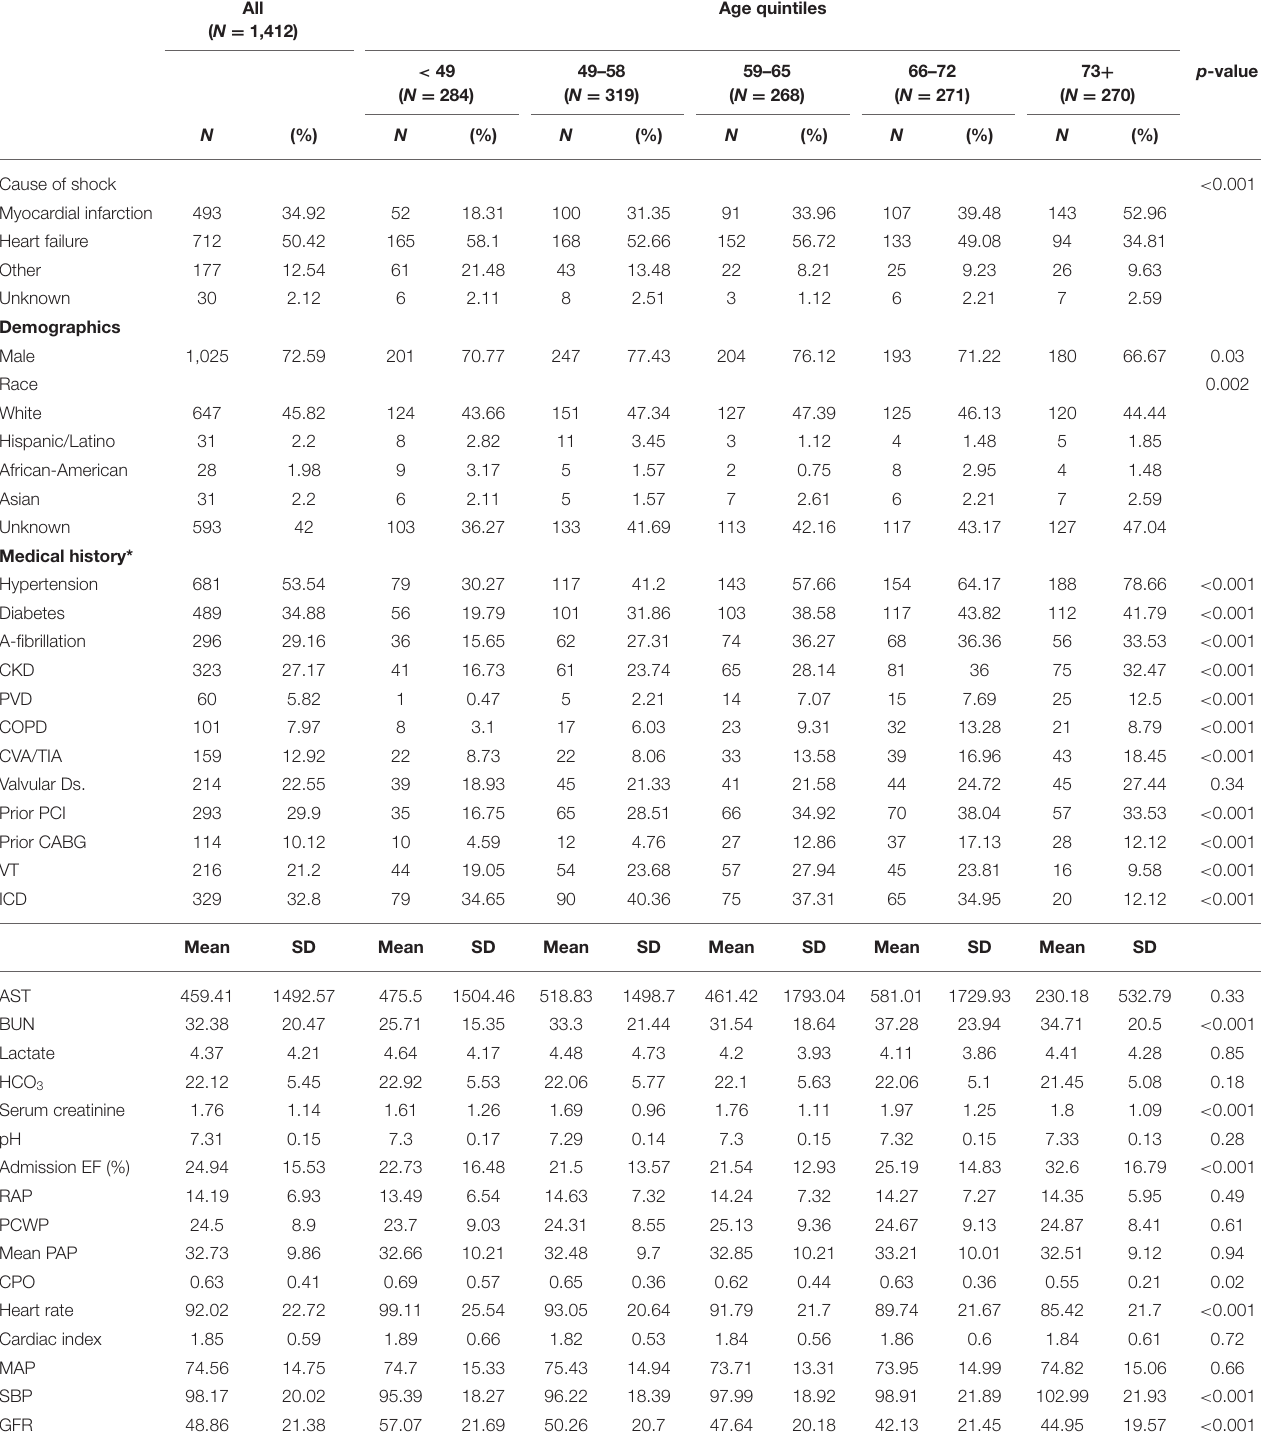
TABLE 1 | Baseline characteristics for patients in cardiogenic shock, at the time of presentation, separated into quintiles by age. All ( N =